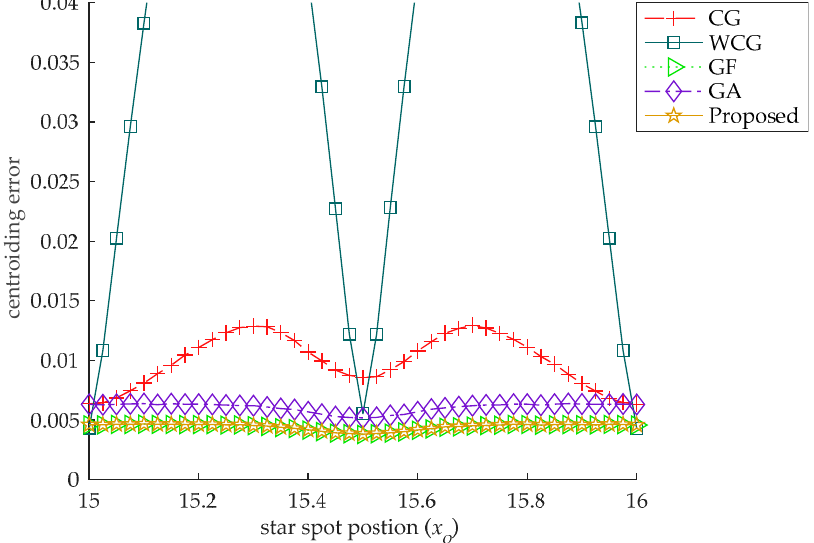
Figure 4. The centroiding error with the star spot at different locations. There is a sine curve in the pixel for the CG and WCG, and the error of the WCG is greater than that of the CG.